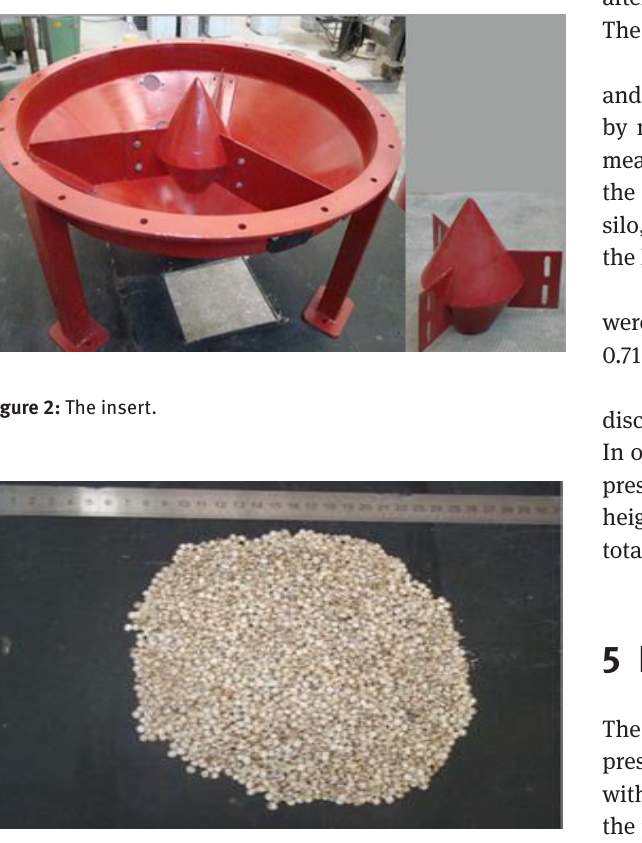
Figure 3: The used granular